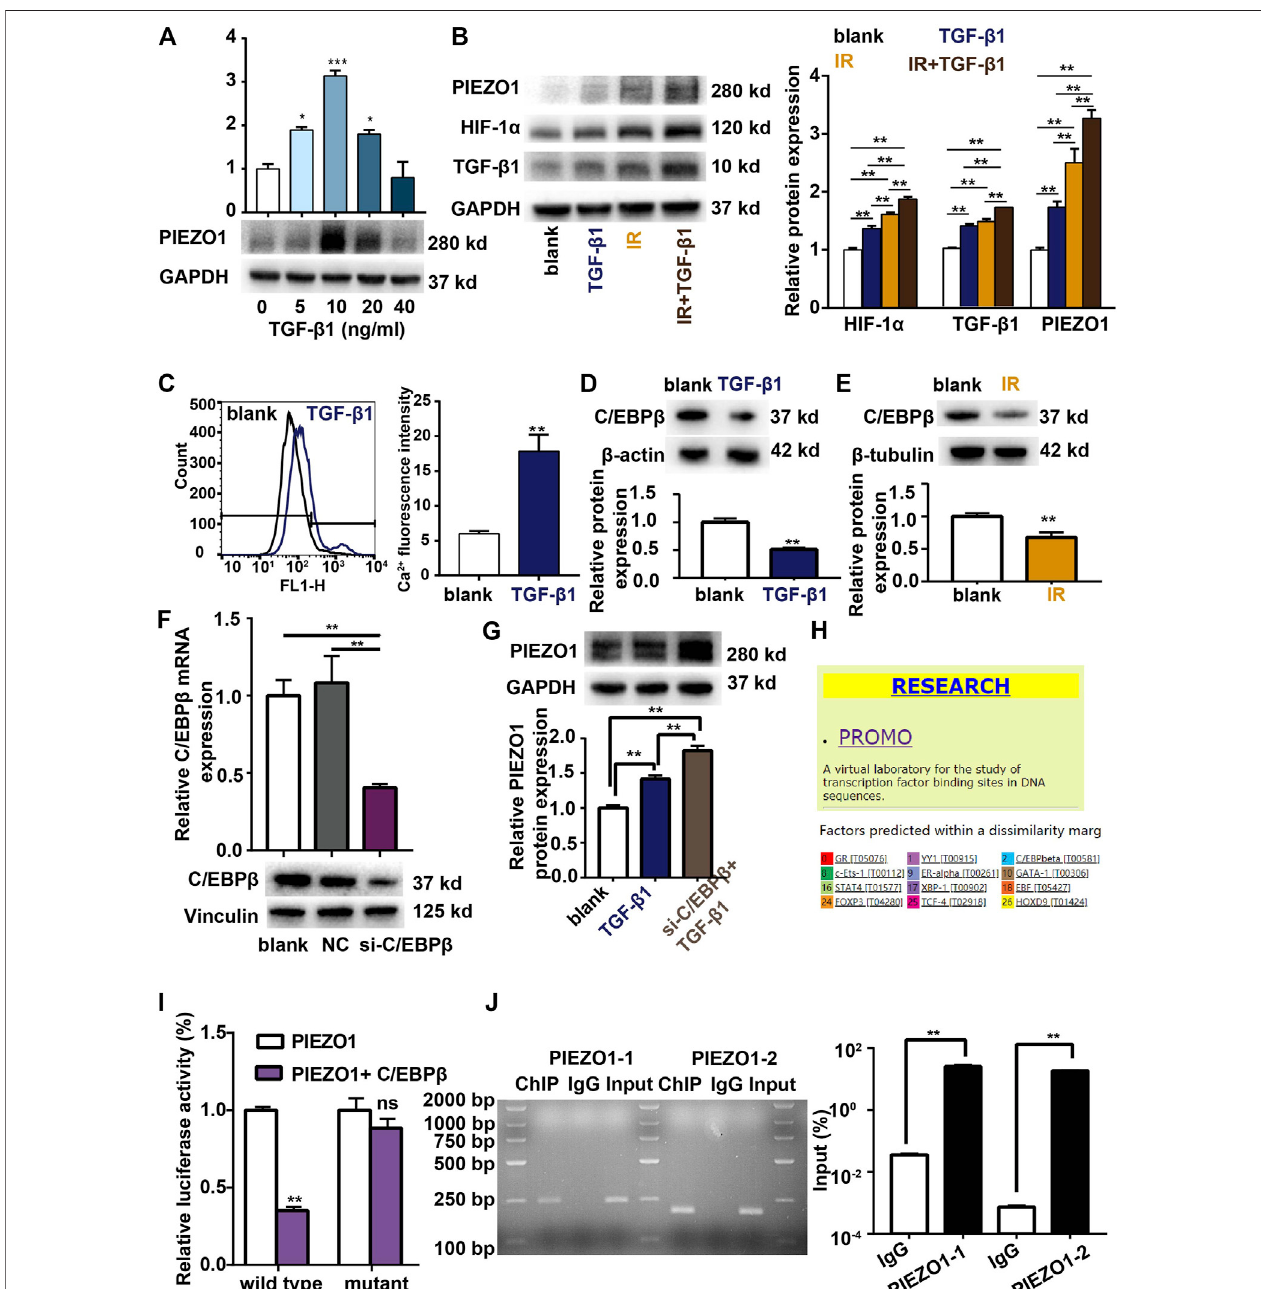
FIGURE 4 | TGF- β 1 promotes PIEZO1 expression through C/EBP β . (A) TGF- β 1 dose-dependently induces PIEZO1 mRNA and protein expression. (B) PIEZO1, HIF-1 α andTGF- β 1proteinexpressionwerefutherenhancedbyadditionofTGF- β 1tocellssubjectdtoirradiation(IR). (C) IntracellularCa 2+ concentrationwasincreased after TGF- β 1 co-culture. (D) TGF- β 1 inhibits C/EBP β protein expression. (E) C/EBP β protein expression was decreased after IR. (F) C/EBP β mRNA and protein expressionweresuccessfulinhibitedbyspeci fi csiRNAtoC/EBP β . (G) ComparedtoTGF- β 1co-culturealone,PIEZO1proteinwasfurtherincreasedwhenC/EBP β expressionwasinhibitedbysiRNAtargetingC/EBP β (si-C/EBP β ). (H) ThePROMO(predictionoftranscriptionfactorbindingsites)databaseindicatesapotentialbinding site of C/EBP β in the PEIZO1 promoter locus. (I) Dual-luciferase reporter assay suggests that C/EBP β binds to PIEZO1 gene promoter. (J) Chromatin immunoprecipitation (ChIP) reporter gene analyses found two binding sites of C/EBP β in the upstream region of the PIEZO1 promoter. Data are presented with the means ± SEMs (n (cid:2) 3). *, p < 0.05; and **, p < 0.01.